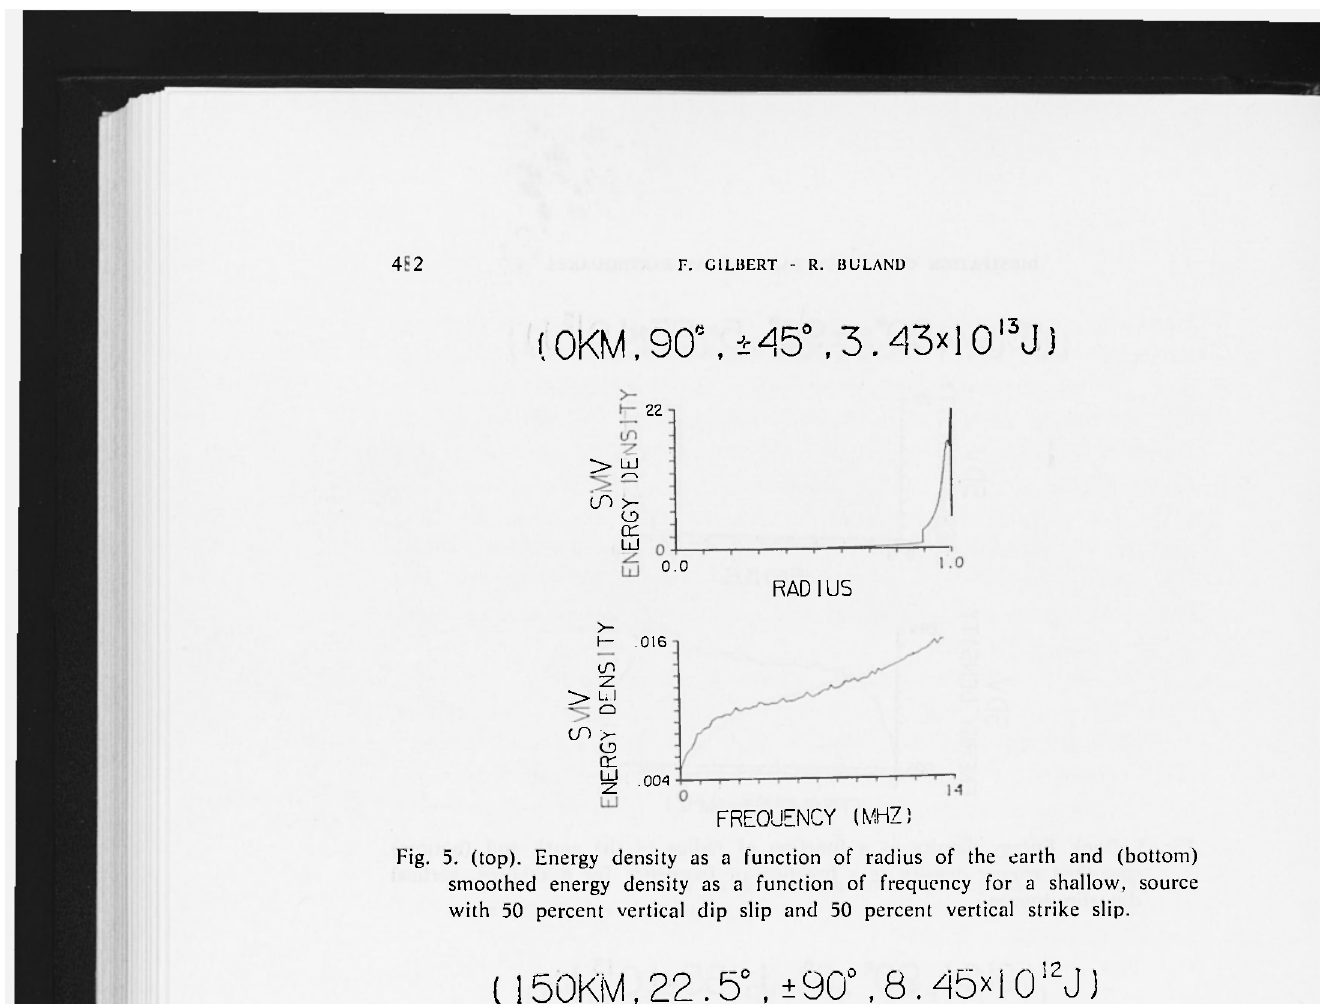
Fig. 5. (top). Energy density as a function of radius of the earth and (bottom) smoothed energy density as a function of frequency for a shallow, source with 50 percent vertical dip slip and 50 percent vertical strike slip.